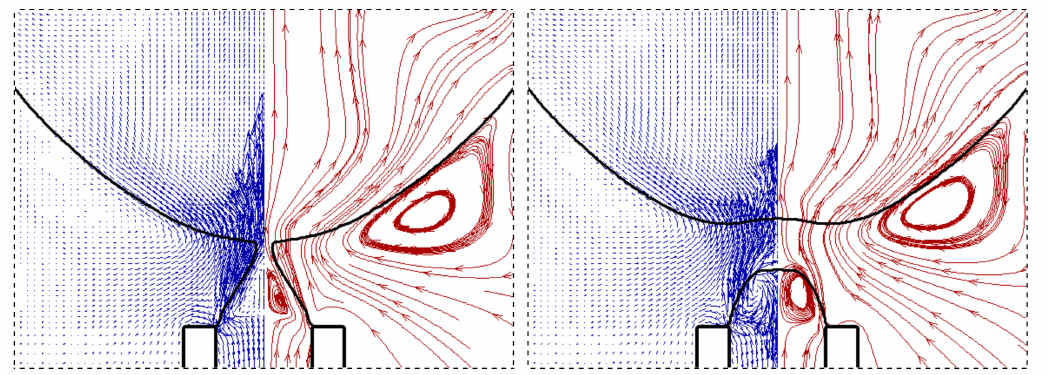
Figure 6. Velocity vectors ( left ) and streamlines ( right ) at the instant of droplet detaching ( q d = 90 mL / h, We = 0.027, Bo =